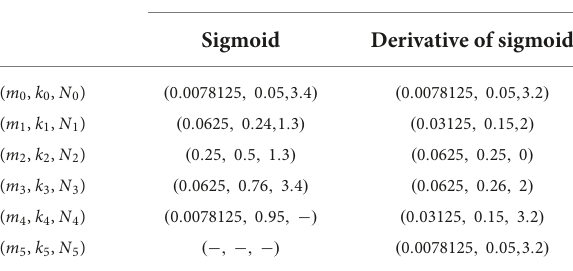
TABLE 2 Coefficients of approximated functions.